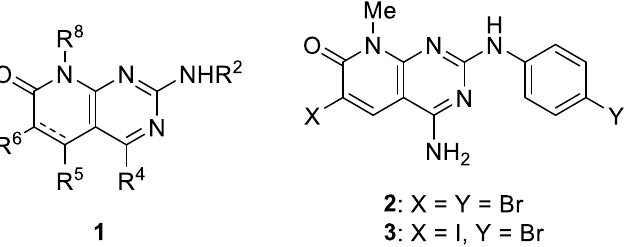
Figure 21. Structure of pyrido[2,3- d ]pyrimidin-7( 8H )-one ( 1 ) and the common starting reagent.